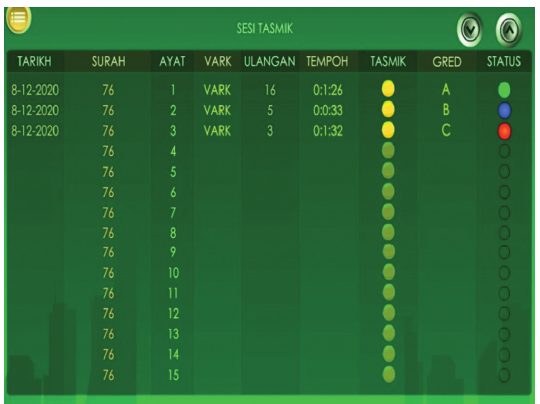
Figure 8: Tasmik